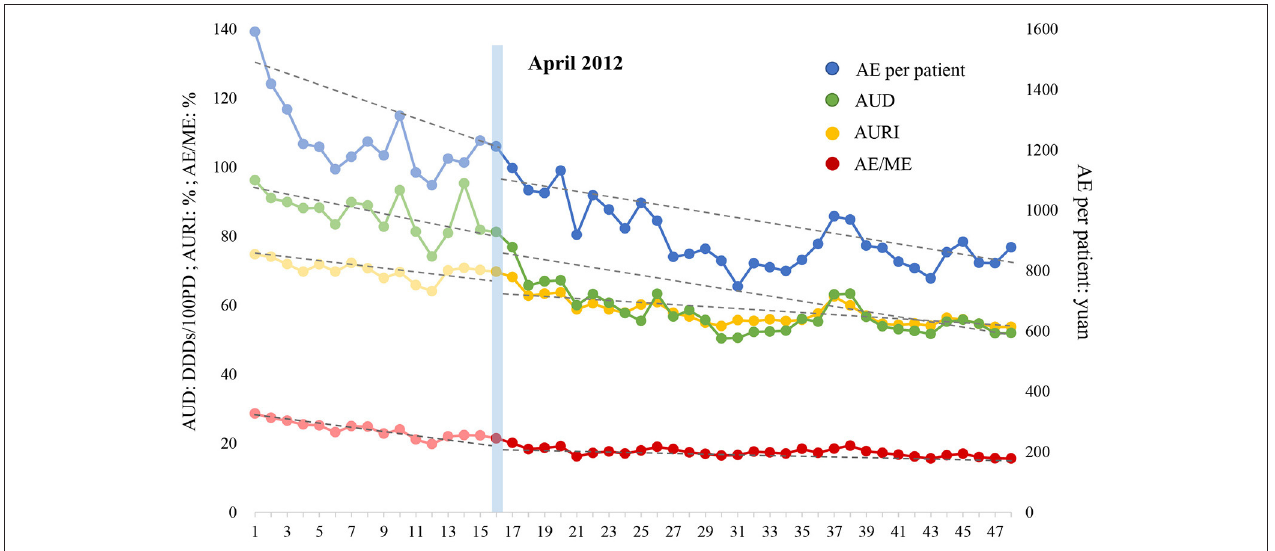
FIGURE 2 | Effect of intensified CSRA policy on four indicators representing inpatient antibiotic use. AURI, antibiotic use rate of inpatients; AUD, antibiotic use intensity, expressed as defined daily doses per 100 patients per day (DDDs/100PD); AE, antibiotic expenditure; ME, medication expenditure.